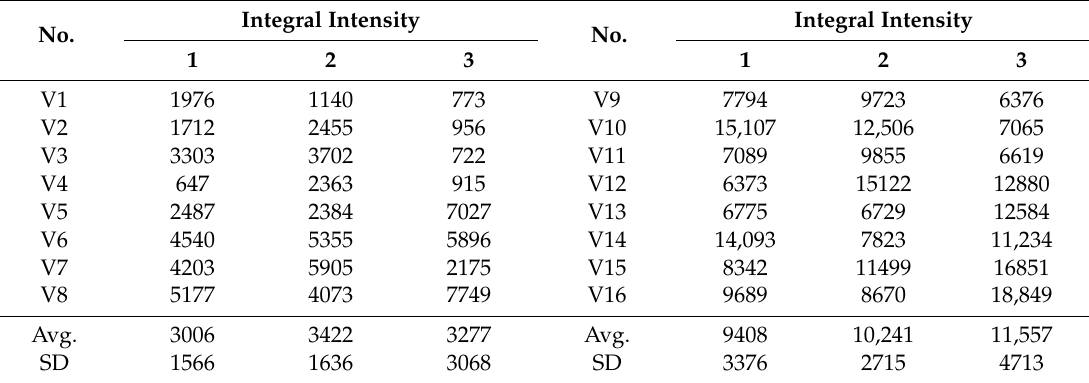
Table 2. Integral intensities of asbestos peaks for standard vermiculite samples with di ff erent ACM concentrations (1% and 3%).